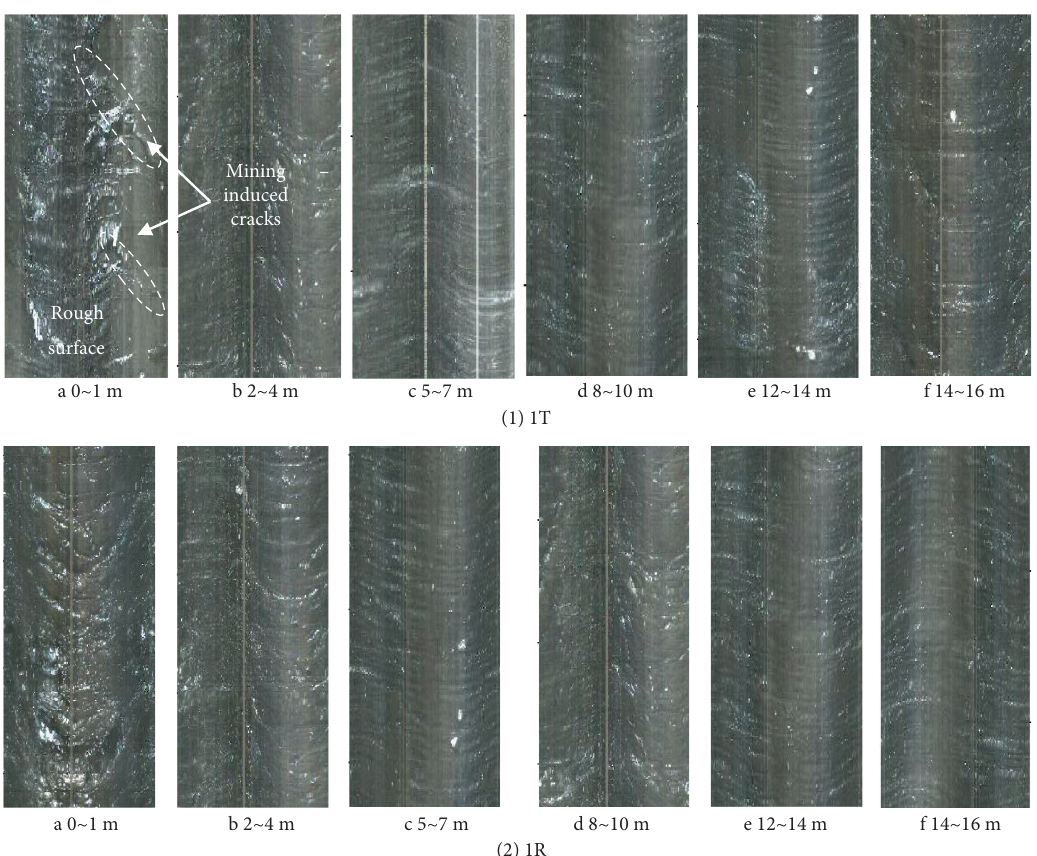
Figure 8: Images of the surface of the borehole in station I.